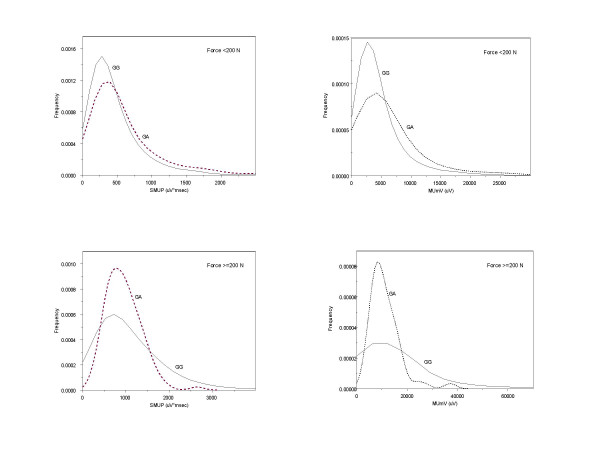
Density distribution of motor unit size for CNTF GG and GA genotypes for force levels less than and greater than 200 N for SMUP and MUmV. The graphs show the frequency distribution of motor units based on either SMUP or MUmV levels for genotypes GG and GA. The graphs show the interaction between CNTF genotype and motor unit properties.